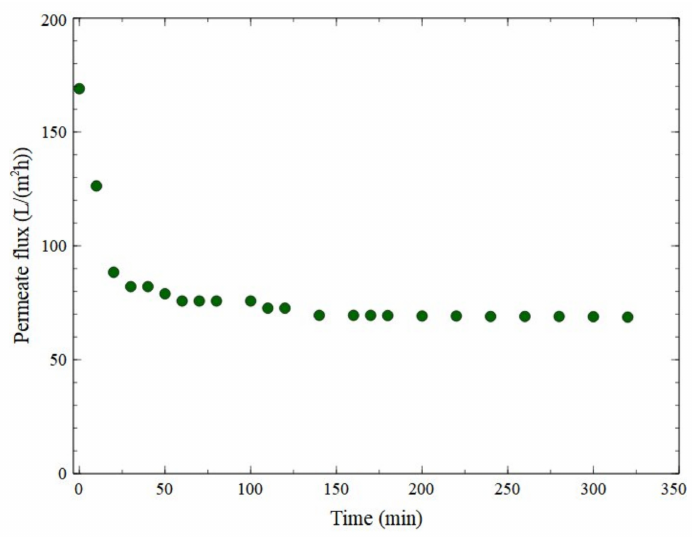
Figure 8. Changes in the permeate flux during the UF process of a fermentation broth (pH =